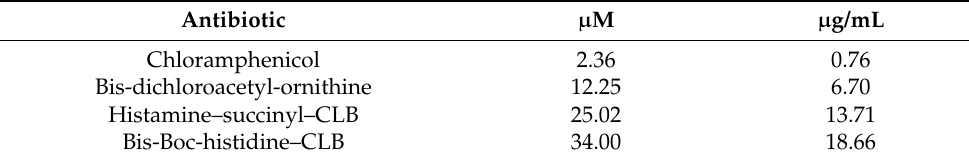
Table 1. EC 50 determination of the most effective derivatives with the E. coli ∆ tolC strain.